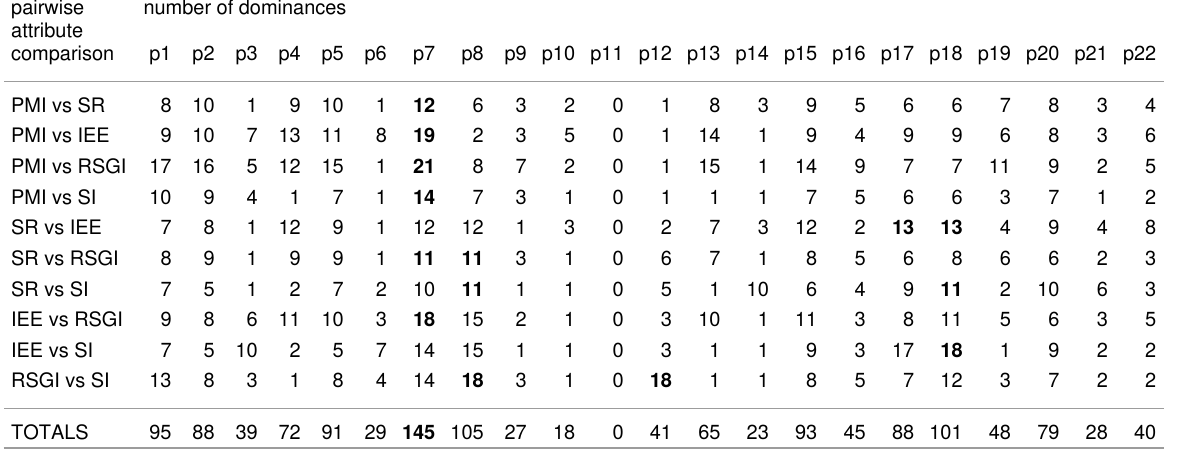
Table 5: Summary of pairwise poset dominance analysis for 22 synthesis plans of vanillin based on 5 attribute categories. a